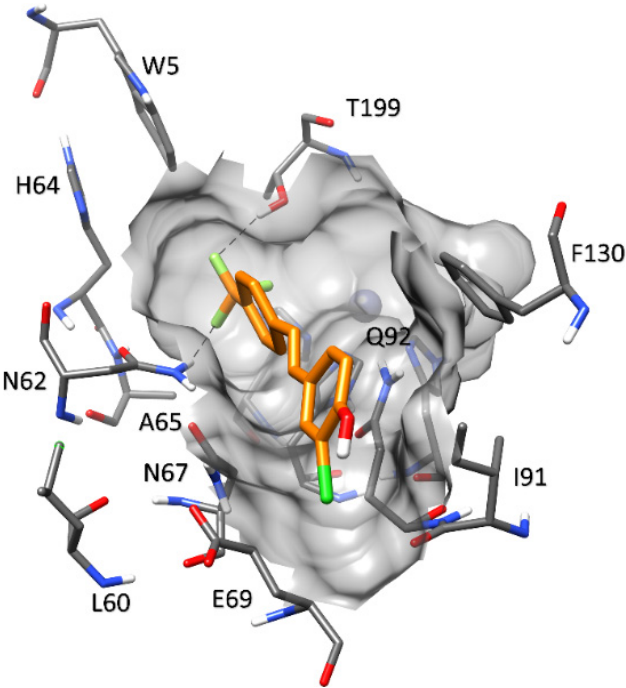
Figure 8. Predicted binding mode of compound 4 in hCA II.